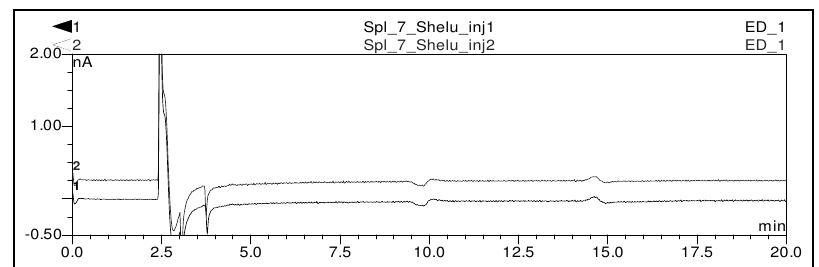
Figure 8. Conductivity detection of sample_Uttarpara for arsenate content (duplicate injections)